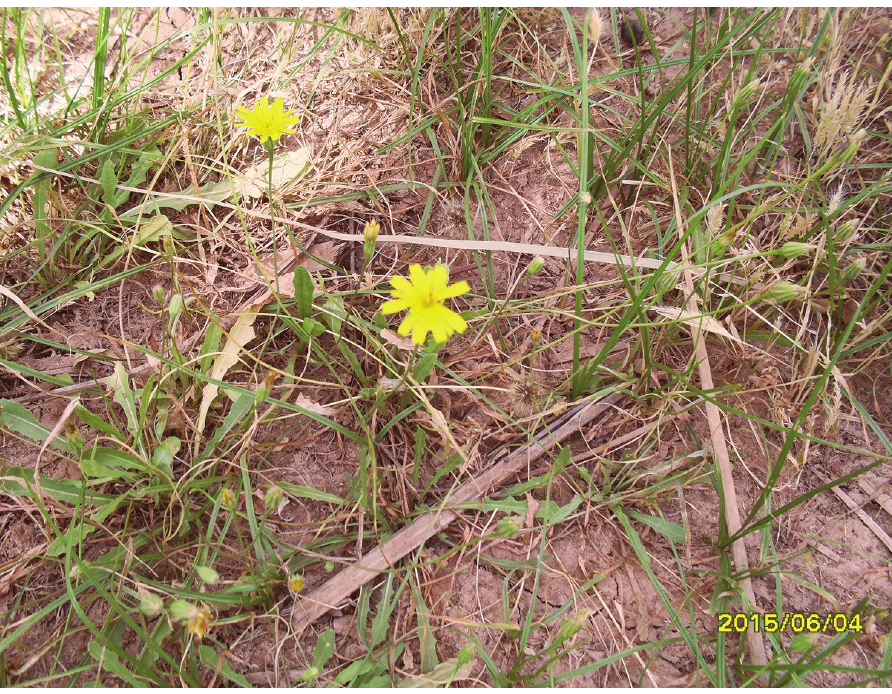
Figure 4. Hypochaeris sp., host plant of Ensina sonchi